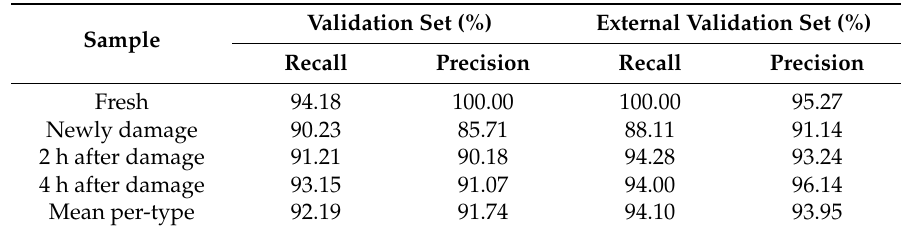
Table 1. PLS-DA performance for validation set and external validation set with 4 types of litchis.